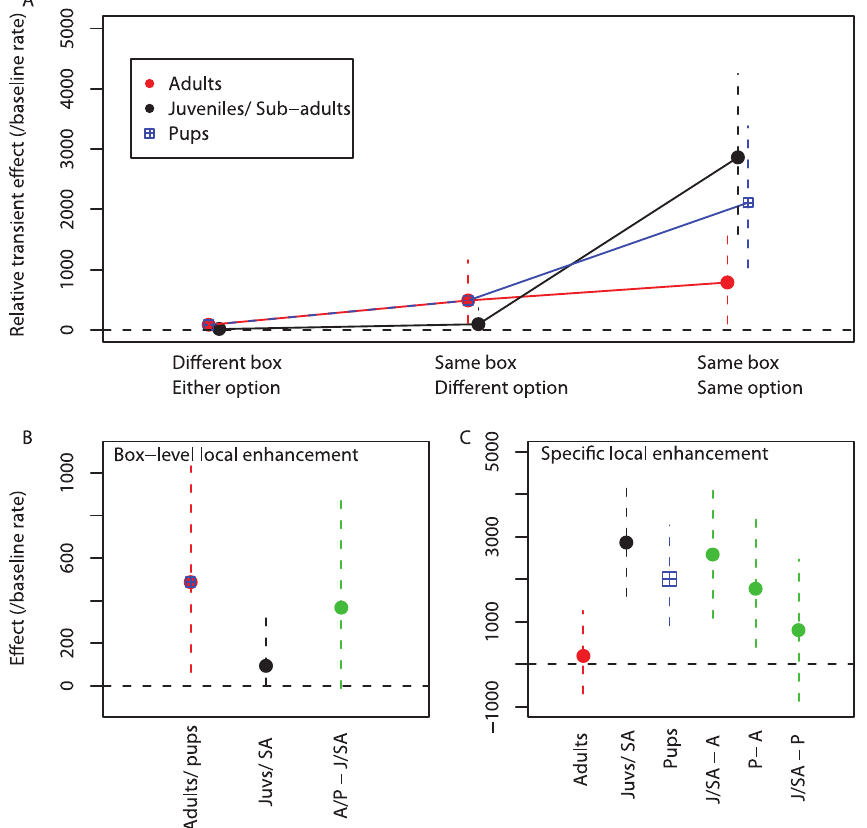
Figure 3. Estimated transient effects. A) Estimated size of the transient increase in rate of interaction at each option immediately following observation, for different age classes of meerkats (taken from the final model). These effects are decomposed into B) box-level local enhancement, influencing rate of interaction with both options at the manipulated box; and C) specific local enhancement, further influencing rate of interaction with the manipulated option. Estimates are the median of the posterior distribution, scaled relative to the estimated median baseline rate of interaction with the flap option. Error bars give the 95% highest posterior density (HPD) interval. Green points and error bars give the estimates of the difference in effect size between different age classes, where A=adult; J/SA= juveniles and sub-adults;